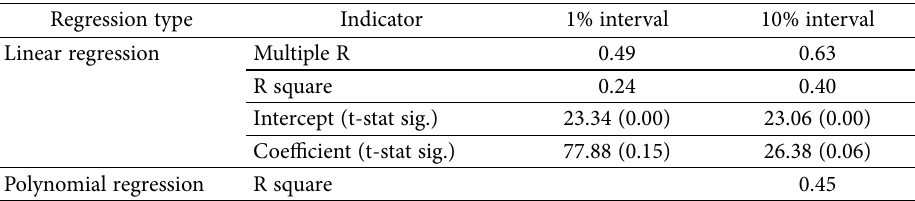
Table 2A. Regression statistics of ROE mean analysis